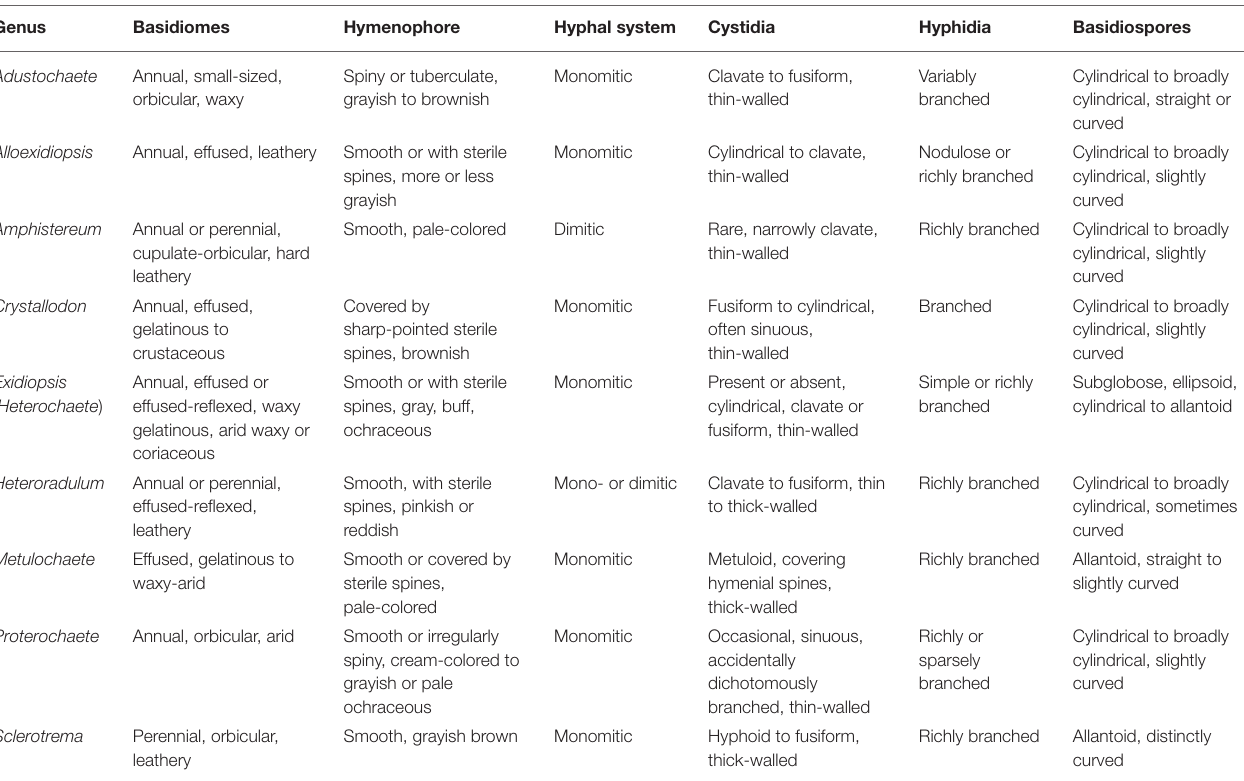
TABLE 2 | Morphological comparison among Alloexidiopsis and related corticioid genera in Auriculariales